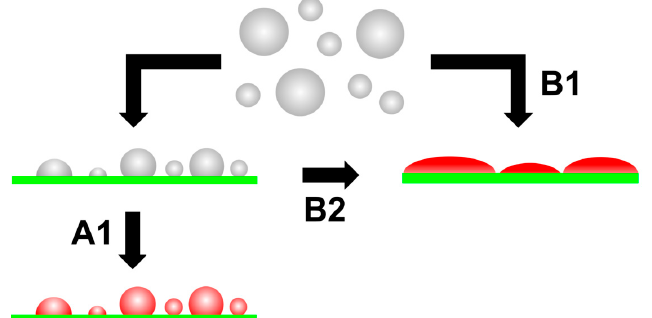
Figure 11. Schematic depiction of interactions between mineral precursors (grey) and the organic matrix (green), involving the subsequent formation of crystalline products (red). ( A1 ) Rapid phase transformation of polymer-induced liquid precursor (PILP) droplets that partially wet the organic surface leads to droplet-shaped mineral particles. Organic–inorganic interactions favoring a Wenzel state (i.e., complete wetting) lead to sheet-like structures via ( B1 ) a matrix-induced crystallization of a PILP phase involving rapid, complete wetting or ( B2 ) an intermediate Cassie–Baxter state involving phase transformations on a timescale significantly slower relative to the dynamics of the PILP phase.